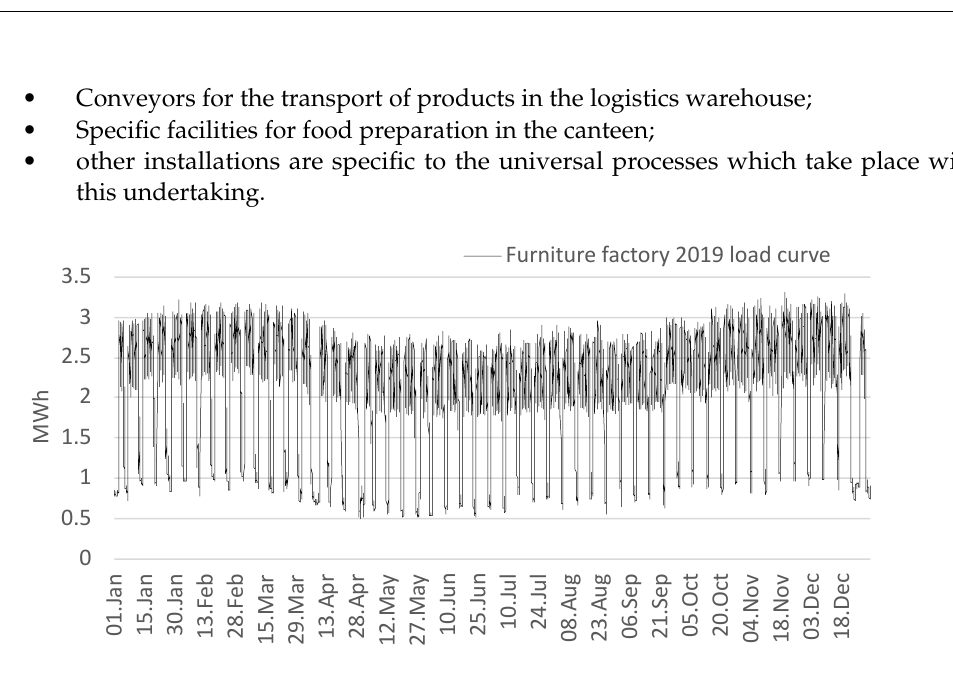
Figure 2. Hourly industrial load curve used for